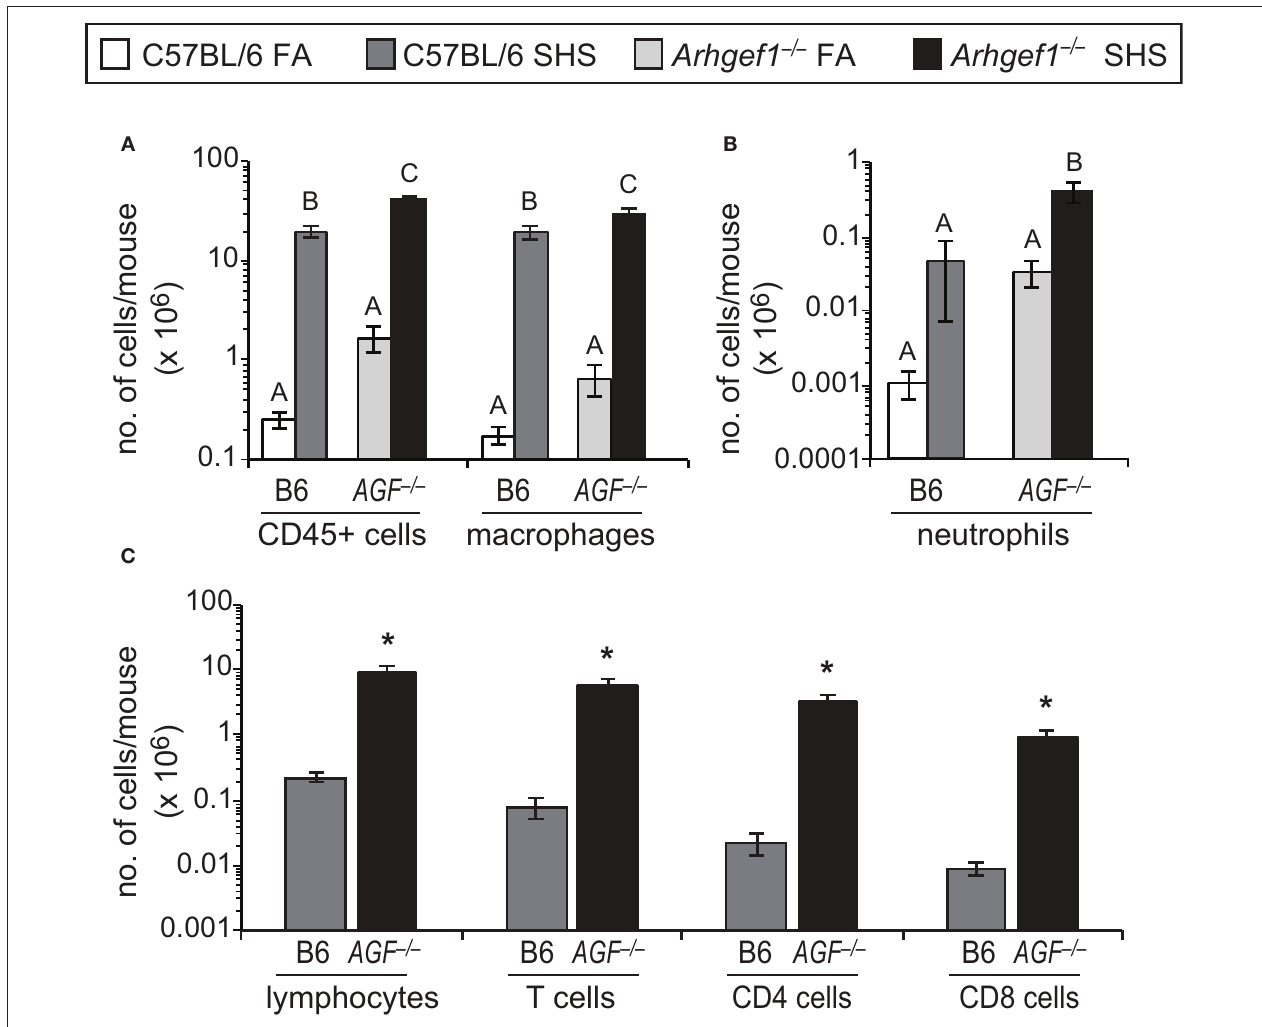
FIGURE 3 | Second hand smoke exposure for 4 weeks leads to increased numbers of pulmonary leukocytes in the airspace. Leukocytes were enumerated and characterized from bronchoalveolar lavage (BAL) as defined in materials and methods. (A) Total number of CD45 + leukocytes and macrophages (F4/80 + ) in BAL from C57BL/6 (B6) and Arhgef1 − / − ( AGF − / − ) mice exposedto filteredair (FA) orsecondhandsmoke(SHS). (B) Enumeration of neutrophils (Gr-1 + ) from C57BL/6 (B6) and Arhgef1 − / − ( AGF − / − ) samples as in panel (A) . (C) Quantitation of lymphocytes, T cells (CD3 + ), CD4 and CD8 cells. Three month old C57BL/6 (B6) mice exposed to FA (open bars, n = 8), 3 month old C57BL/6 (B6) mice exposed to SHS for 4 weeks prior to harvest